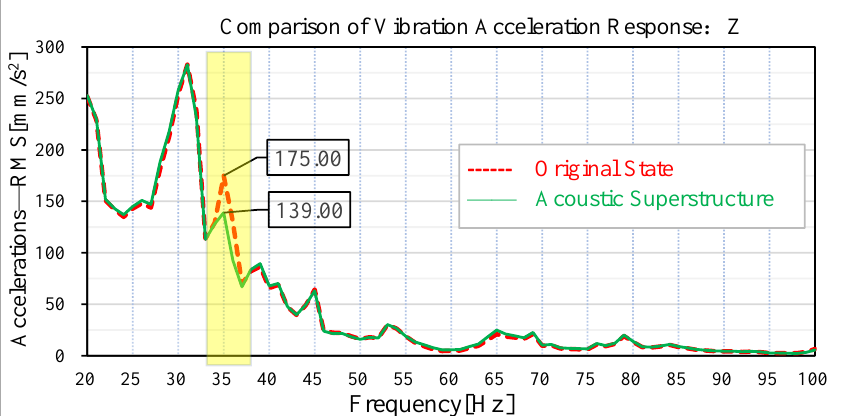
Figure 21. Comparison of x-direction vibration response of sheet metal parts of the tail door.